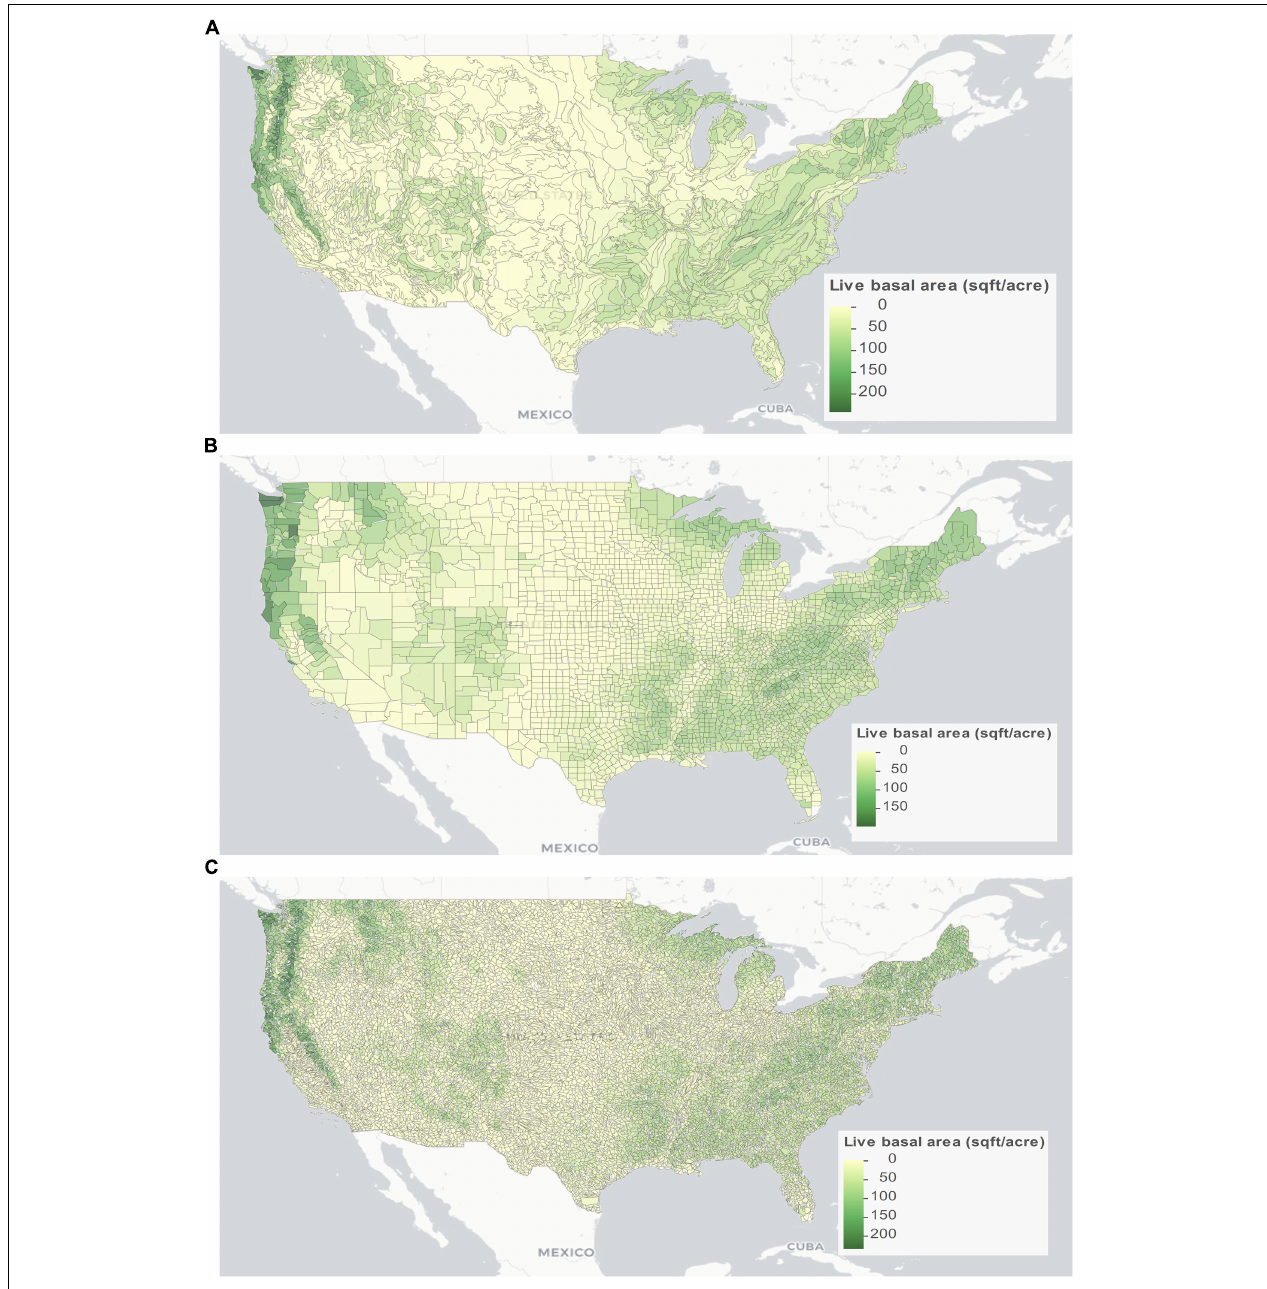
FIGURE 6 | Small area estimates of basal area for (A) ecosubsections, (B) counties, and (C) watersheds based predominantly on area-level